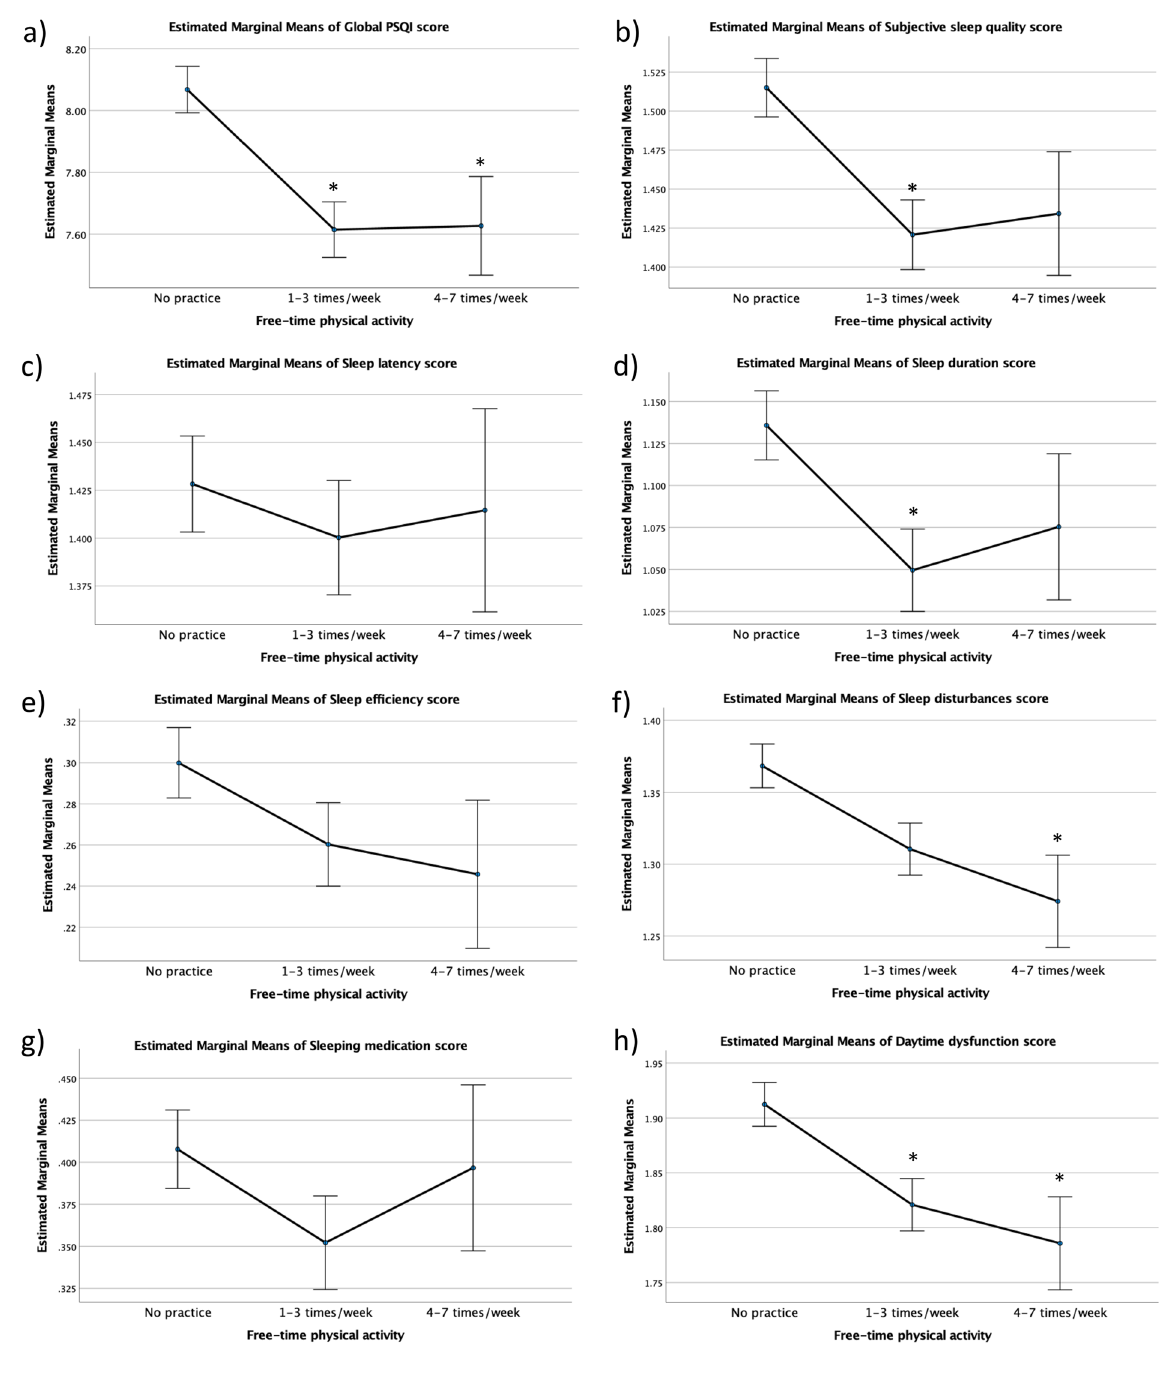
Figure 2. Adjusted estimated marginal means of the Pittsburgh Sleep Quality Index score and its components by frequency of free-time physical activity in Brazilian university students. Values were obtained with ANCOVA models adjusted for sex, age, weight status, alcohol intake, tobacco smoking, fruit consumption, social support and depressive